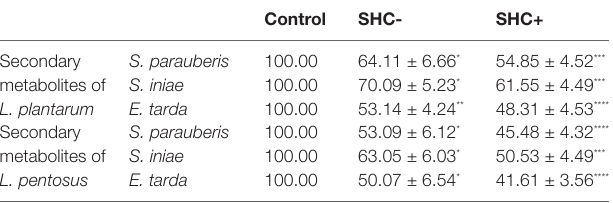
TABLE 2 | Effects of secondary metabolites produced by LAB on pathogenic bacterial growth